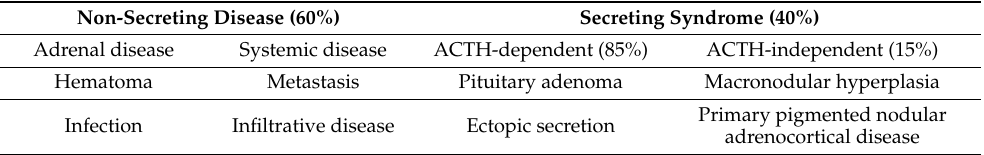
Primary pigmented nodular adrenocortical